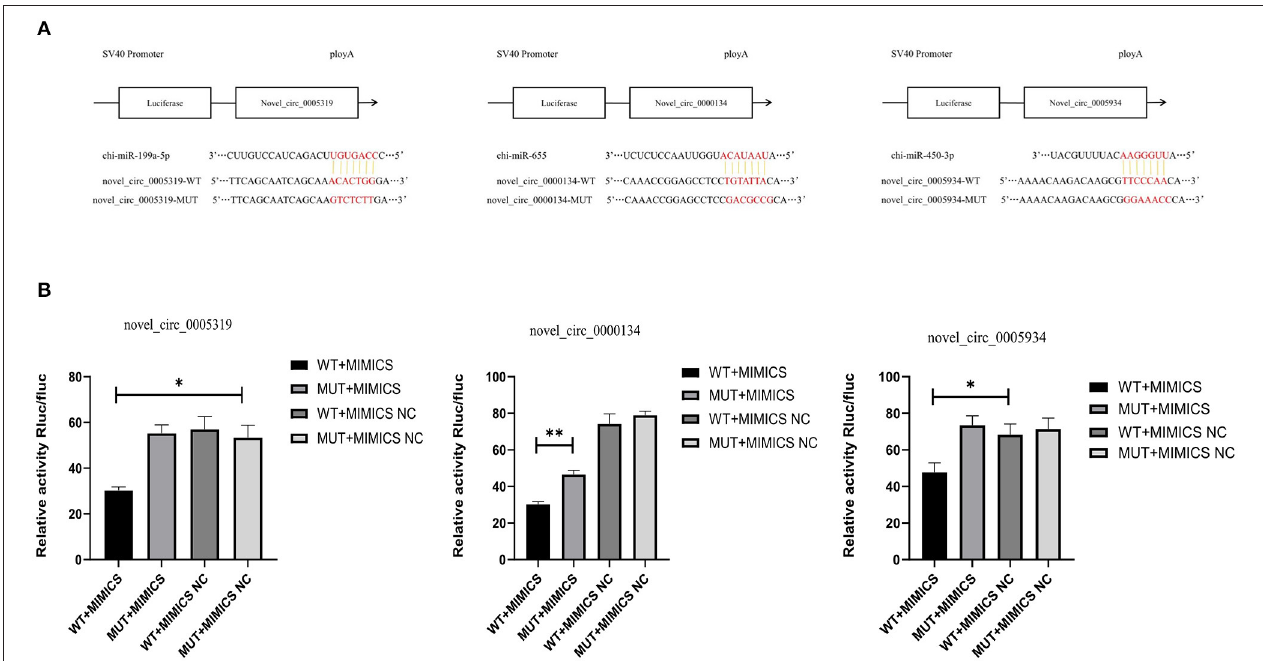
FIGURE 8 | The prediction and verification binding sites of the circRNAs. (A) The predicted binding sites of miRNA-circRNA pairs. (B) Verification of dual Luciferase reporter